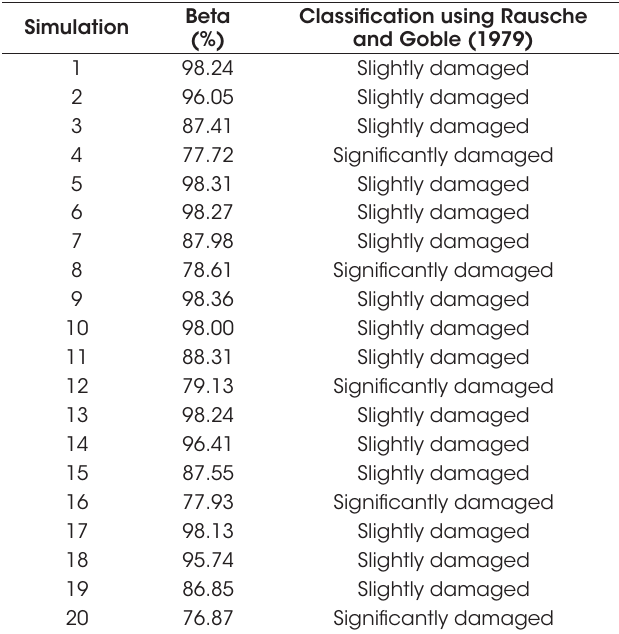
Summary of Beta values (%) obtained in Simulations 1 to 20